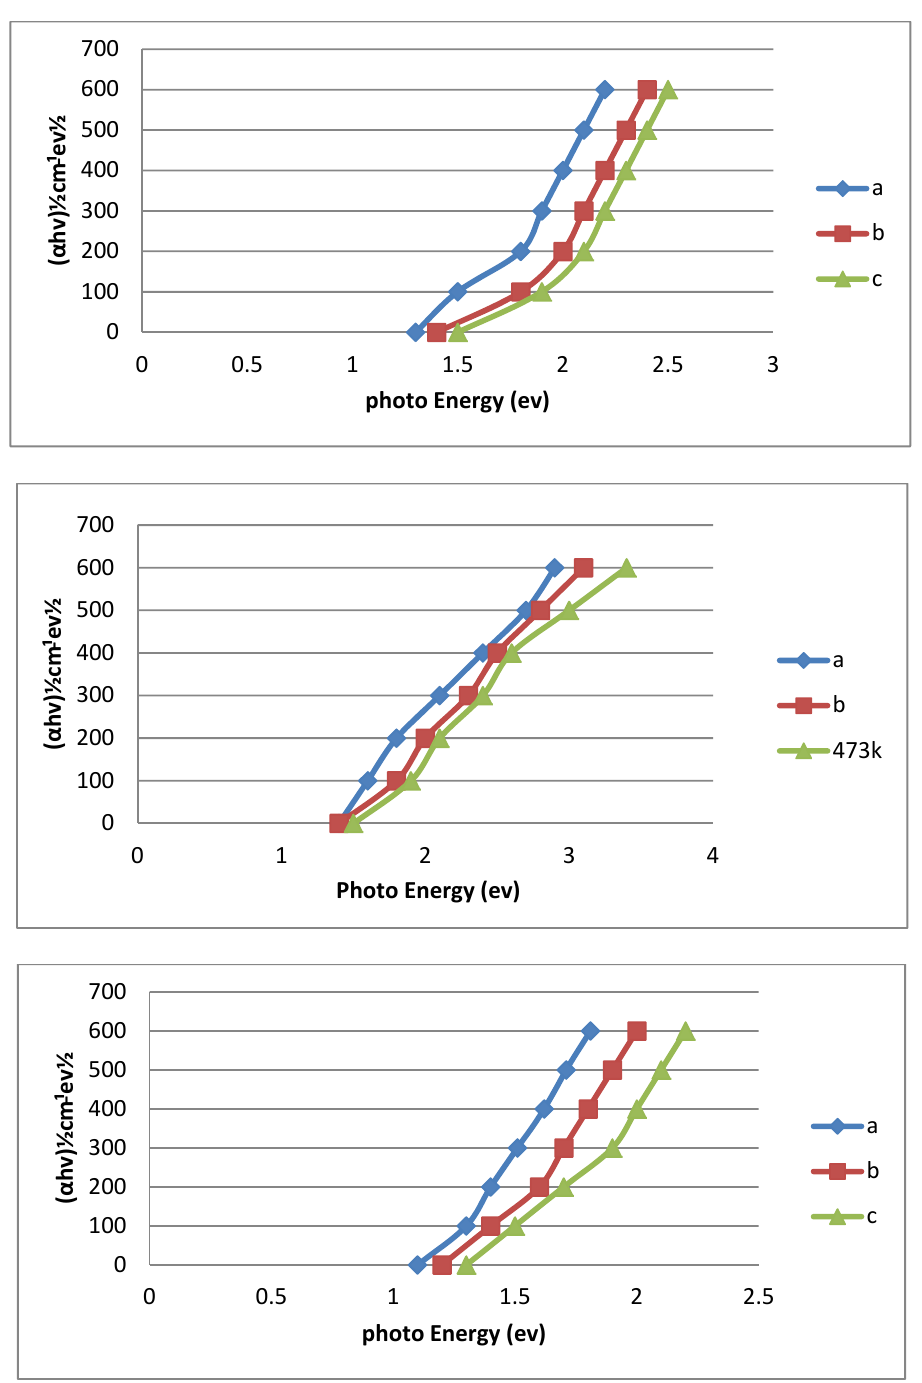
Fig. 5: Optical energy of Ge